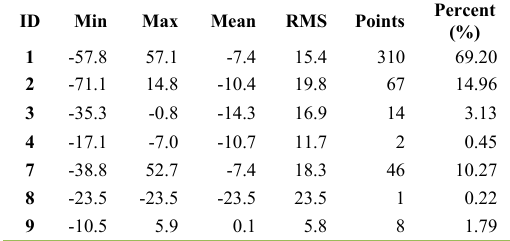
Table 3. Statistics of the elevation difference between ASTER GDEM2 and GPS/GCPs separating into GlobCover land cover classes. Unit is metres.